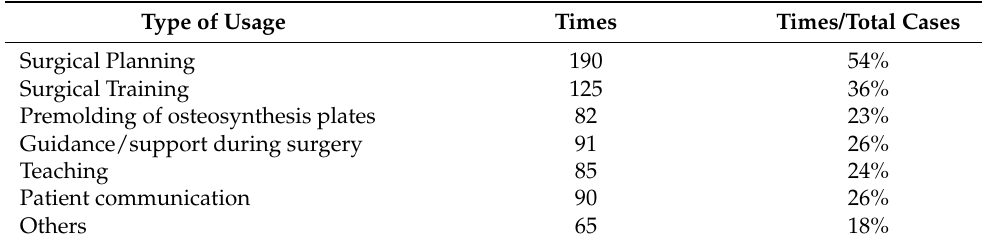
Table 1. Type of uses of requests for 3D